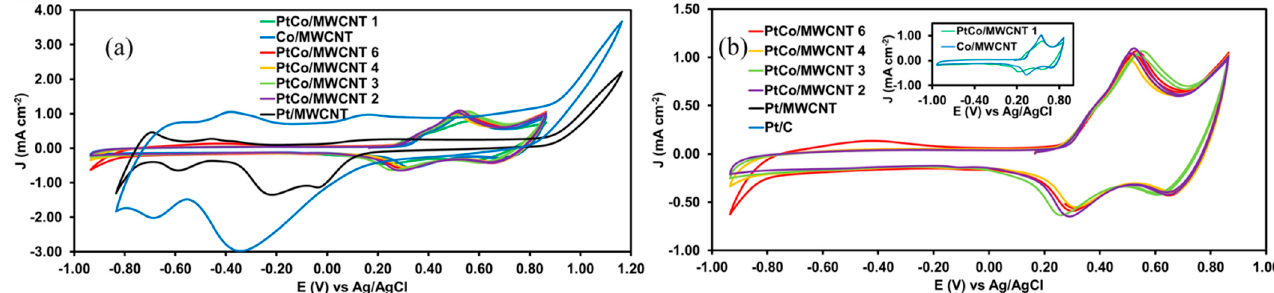
Figure 3. ( a ) Cyclic voltammograms of PtCo/MWCNT catalysts after the application of a potentiostatic pulse of − 120 mV for 3 min under a CO atmosphere. ( b ) Cyclic voltammograms of PtCo/MWCNT catalysts in the pure electrolyte solution. The solution was H 2 SO 4 0.5 M at a scan rate of 100 mV s − 1 .